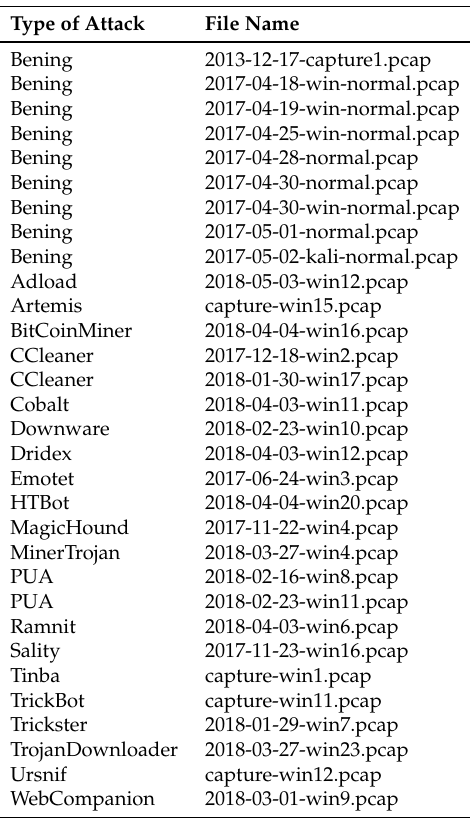
Table 8. Files used to create the NetML dataset.